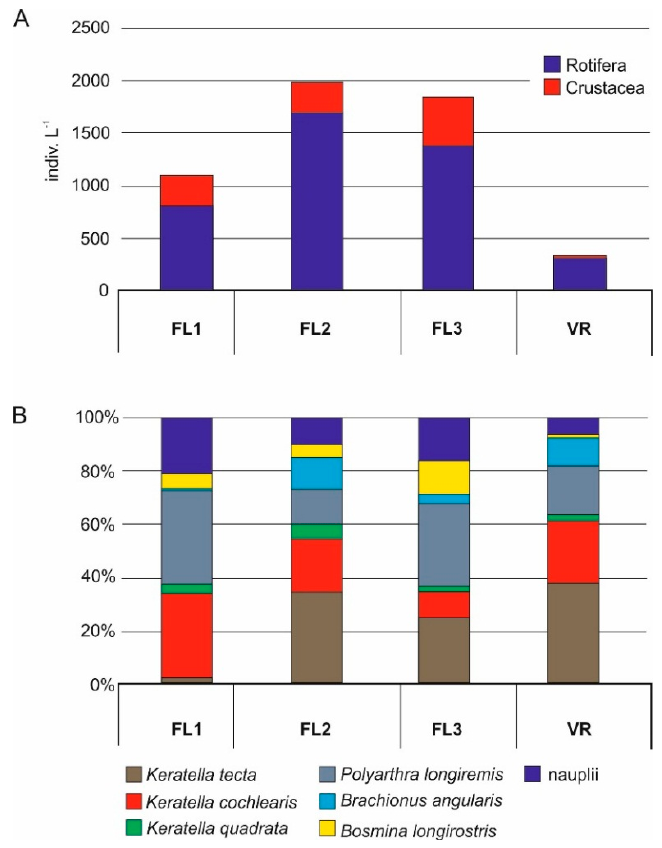
Figure 4. Zooplankton density (ind L − 1 ) in the investigated floodplain lakes (FL1—isolated, FL2—transitional, FL3—connected) and in the Vistula River (VR) ( A ); Percentage share of dominant taxa in zooplankton density in the studied lakes and in the Vistula River ( B ).